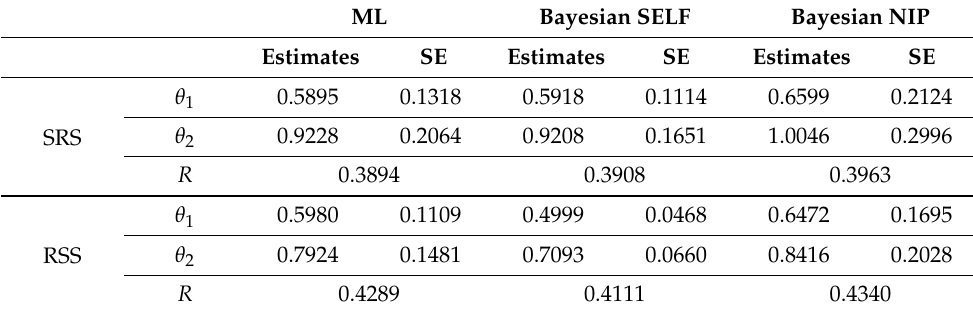
Table 10. ML and Bayesian methods for SRS and RSS.